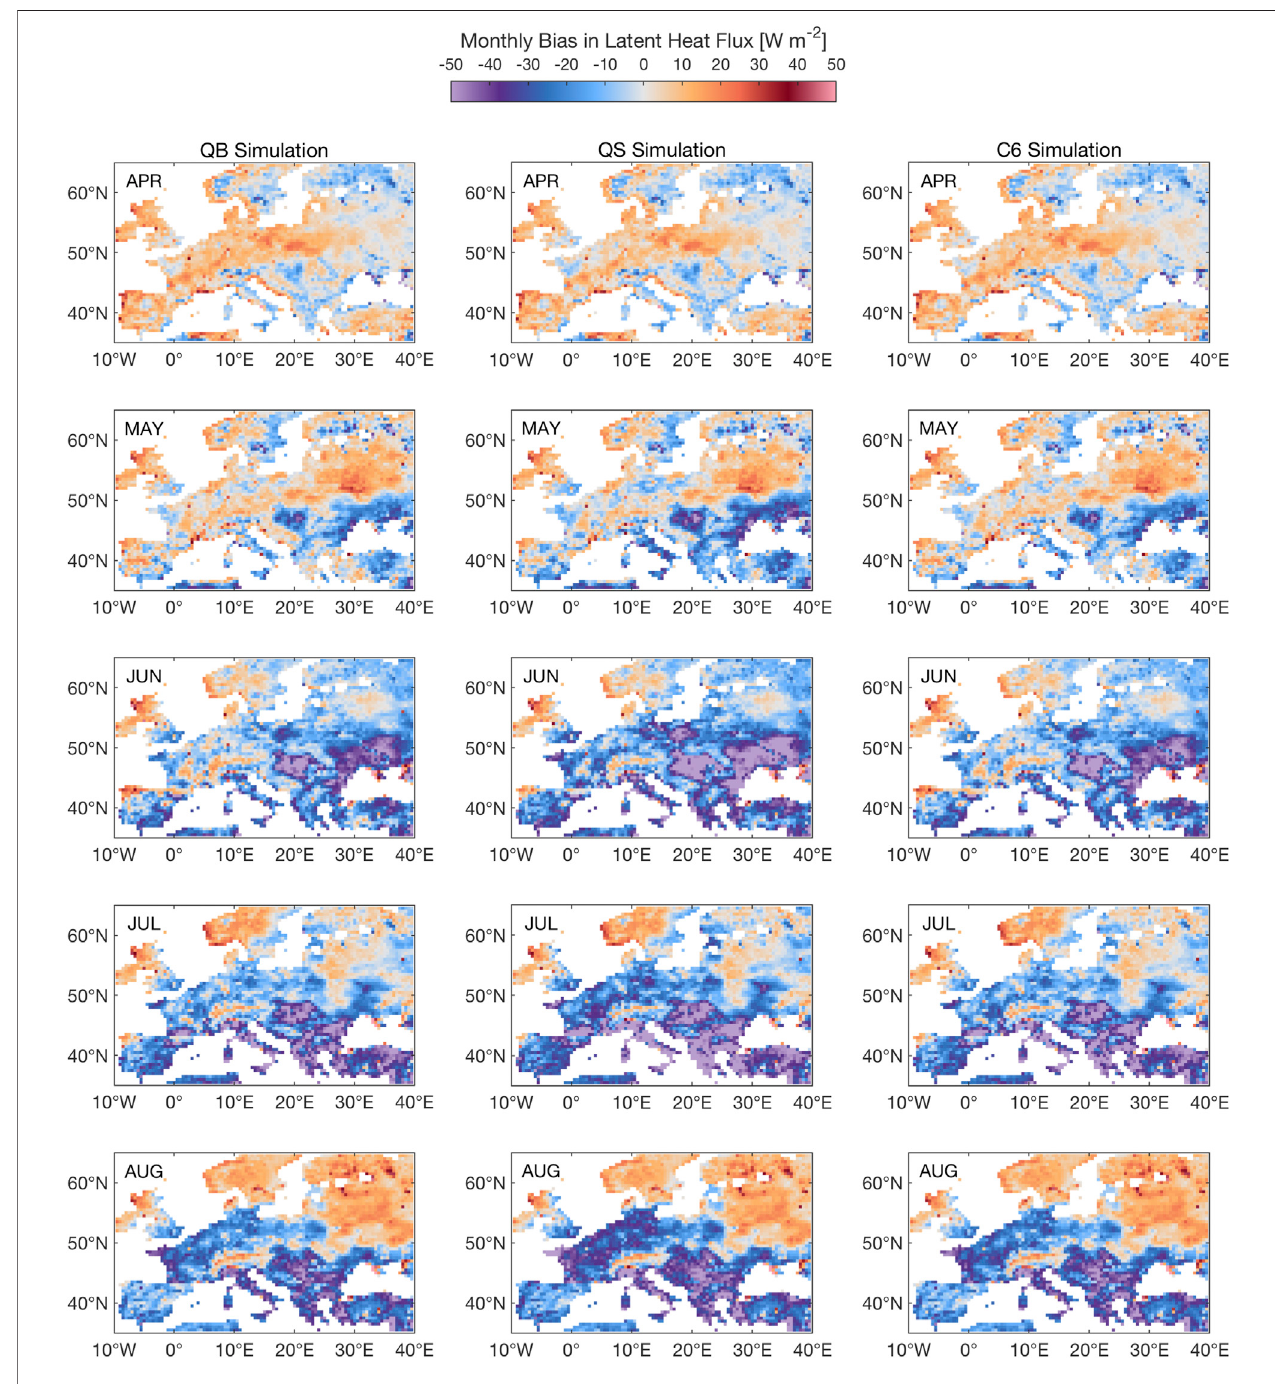
FIGURE 10 | Seasonal evolution of Latent Heat Flux (LE) response to the 2003 heat wave for simulations QB, QS, C6 (as compared to FLUXCOM). The 2003 season starts at the top row, with the April 2003 monthly mean response, and ends in August 2003, with the monthly mean response. Units: W m − 2 .